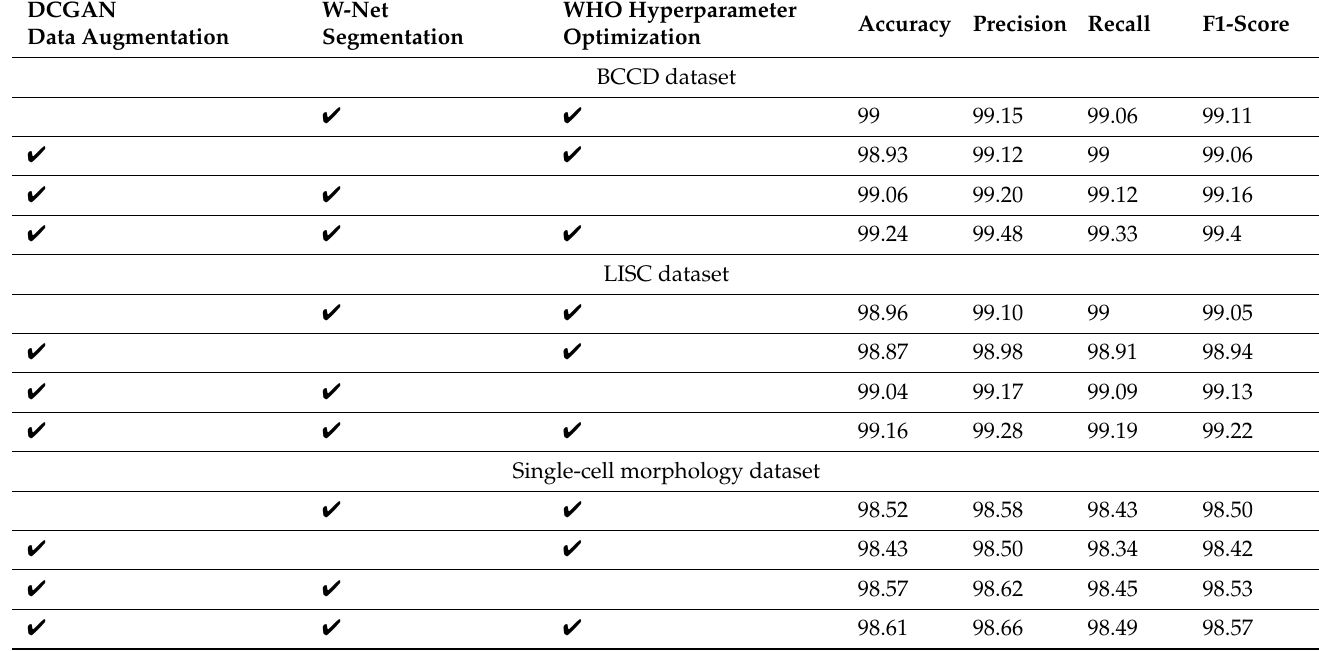
Table 7. Impact of the various modules on proposed